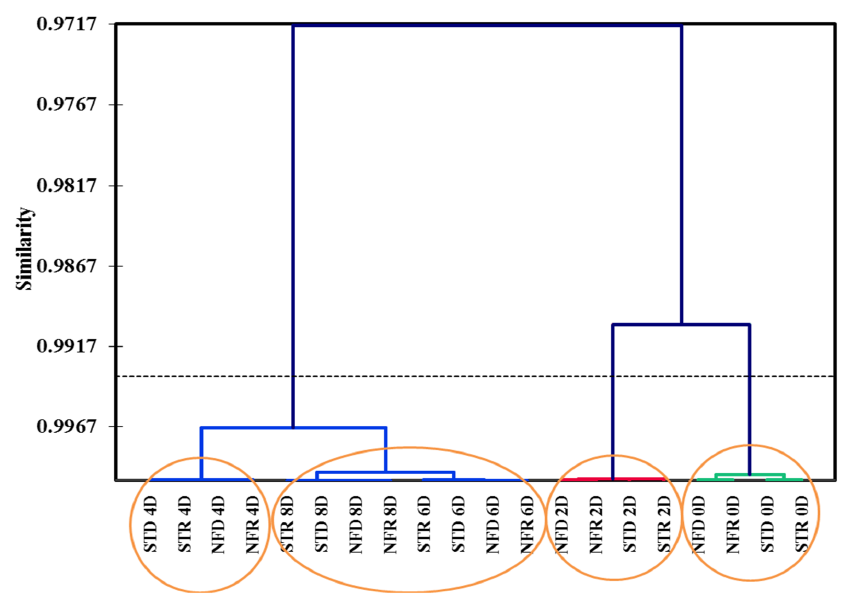
Figure 8. Agglomerative hierarchical clustering analysis of ‘Nam Dok Mai Si Thong’ mangoes from the dry and rainy season at different ripening stages ( p ≤ 0.05). STD, dry season ‘Nam Dok Mai Si Thong’; STR, dry season ‘Nam Dok Mai Si Thong’; NFD, dry season ‘Nam Dok Mai No. 4’; NFR, rainy season ‘Nam Dok Mai No. 4’; 0–8 D, 0–8 days of ripening. Blue branch: fruits at 4 D, 6 D and 8 D at ripening stages, red branch: fruits at 2 D at ripening stages and green branch: fruits at 0 D ripening